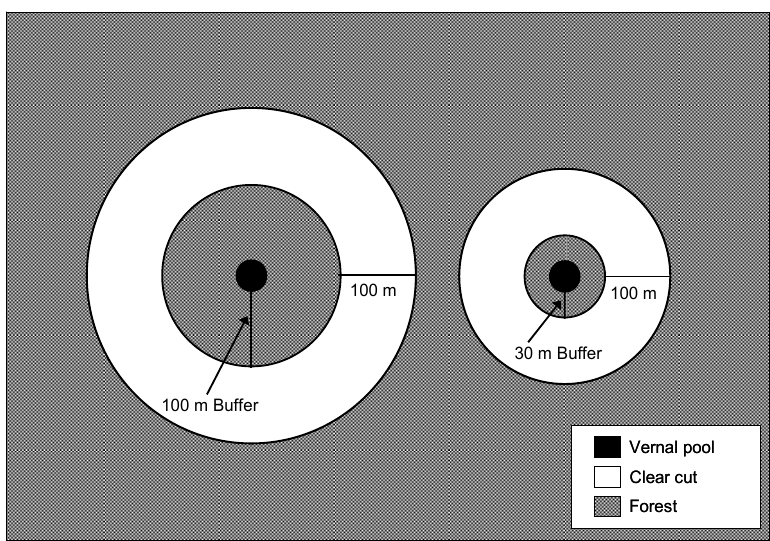
Figure 1. Experimental design implemented at 11 natural ephemeral pools in east-central Maine, USA. Undisturbed buffers of either 100 m (left; n = 4) or 30 m (right; n = 4) were left adjacent to pools and 100 m wide clearcuts were created around the buffers. Forest beyond the clearcut was undisturbed. No cutting occurred at reference pools (not shown; n = 3)